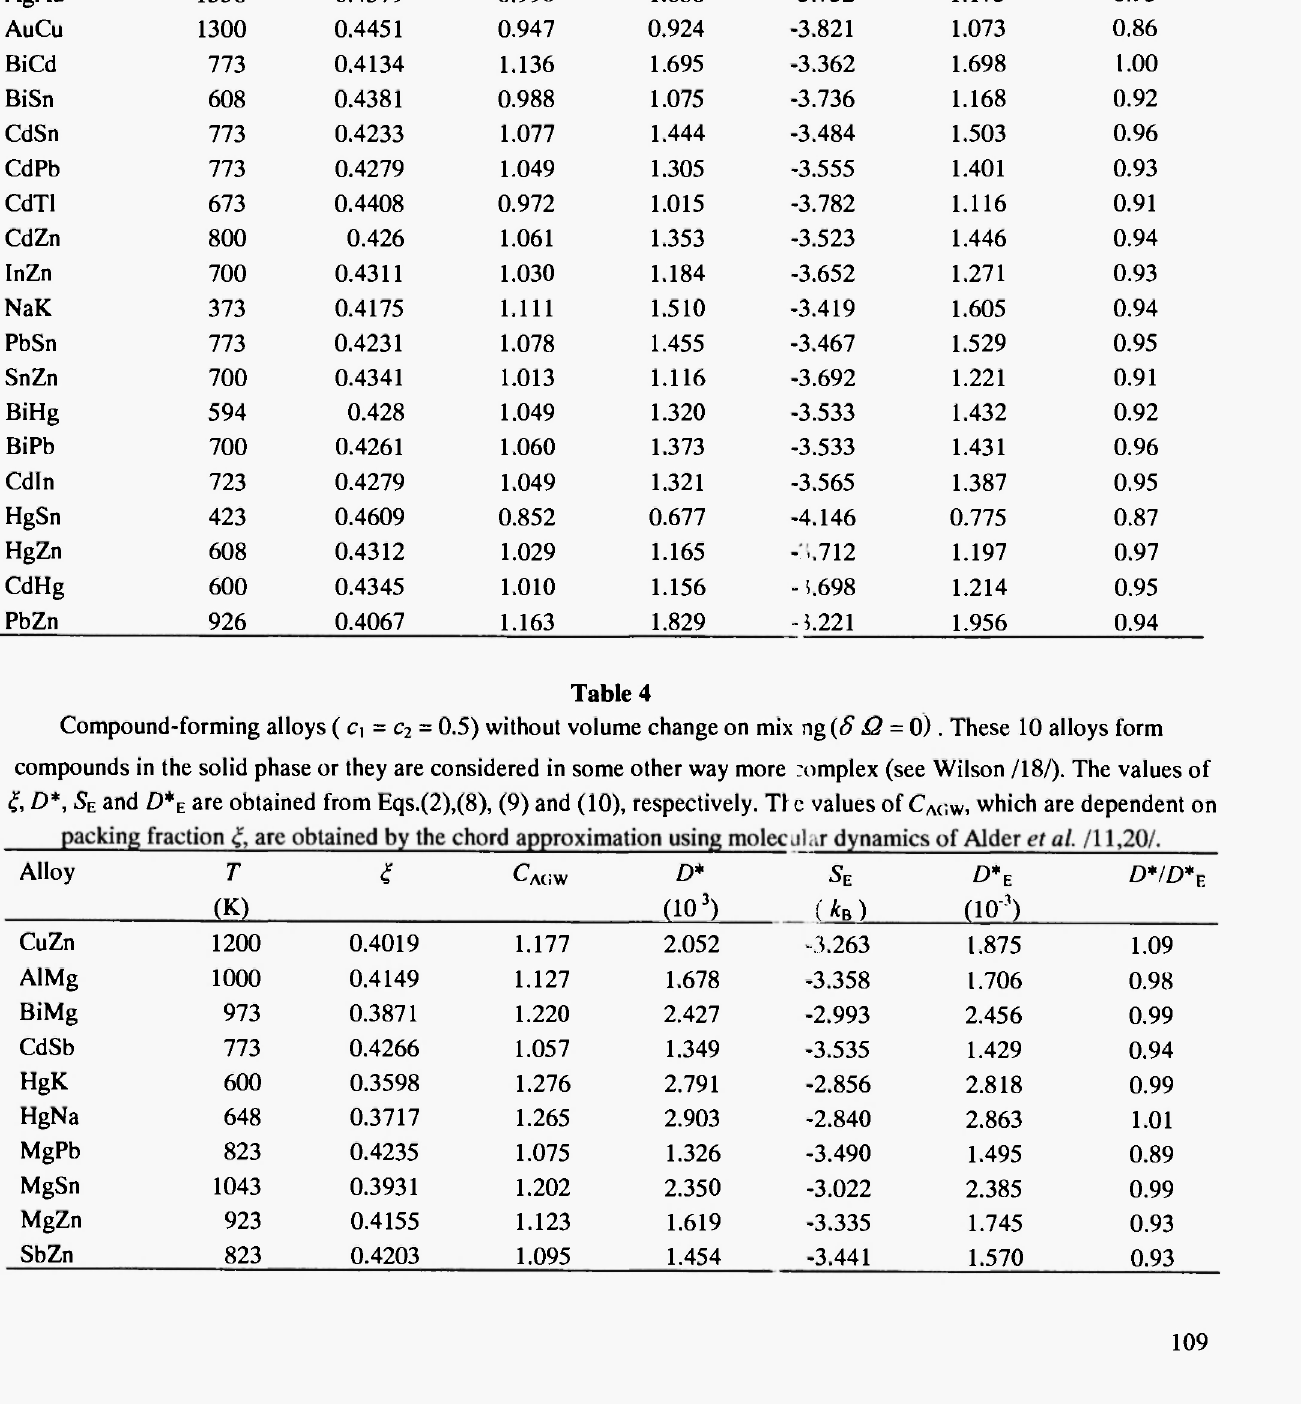
Simple alloys (c, = c 2 = 0.5) without volume change on mixing (<? Ω = 0). These 19 alloys are considered simple in the sense that they do not form compounds in the solids. The values of ξ , D*, S E and D* E are obtained from Eqs. (2),(8), ' (9) and (10), respectively. The values of C A(;w , which are dependent on packing fraction ξ, are obtained by the chord approximation using molecular dynamics of Alder et al. /11,20/.